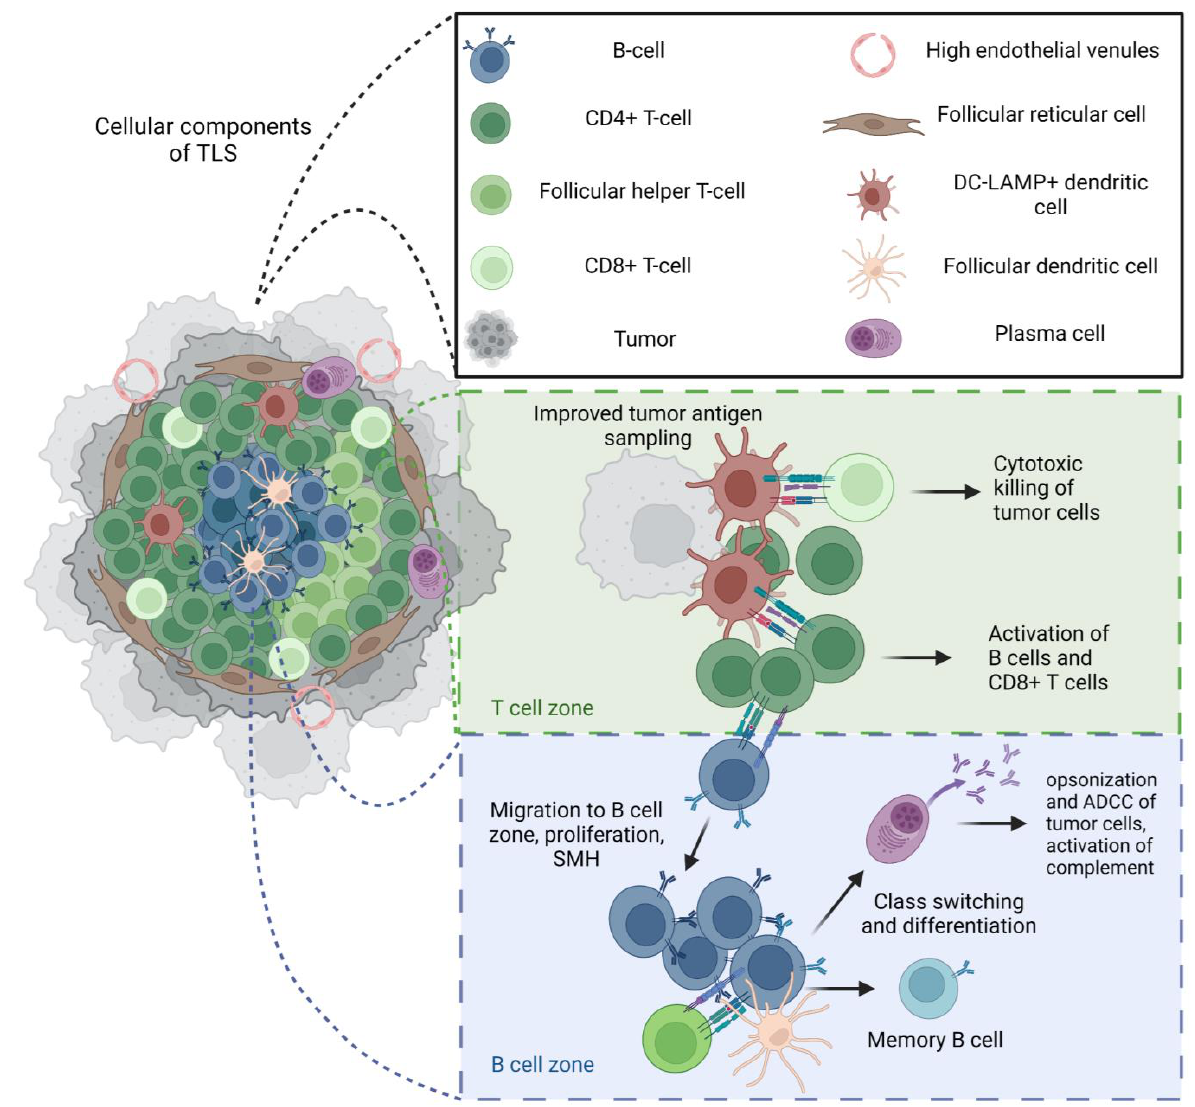
Figure 2. Structure and function of mature tertiary lymphoid structures (TLS). Intra-tumoral B cells in sarcoma may be scarce and diffuse, and/or associated with organized anti-tumor immune responses within tertiary lymphoid structures. When mature, TLSs have been associated with a